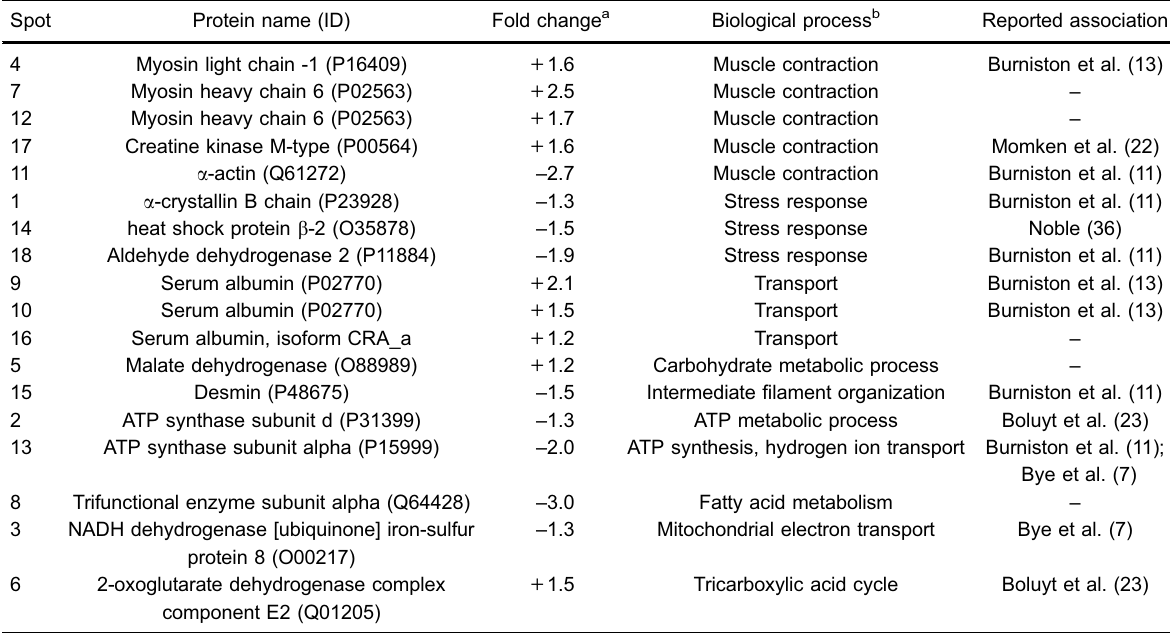
Table 2. Data of differentially expressed proteins between high running performance (HRP) and low running performance (LRP) groups.